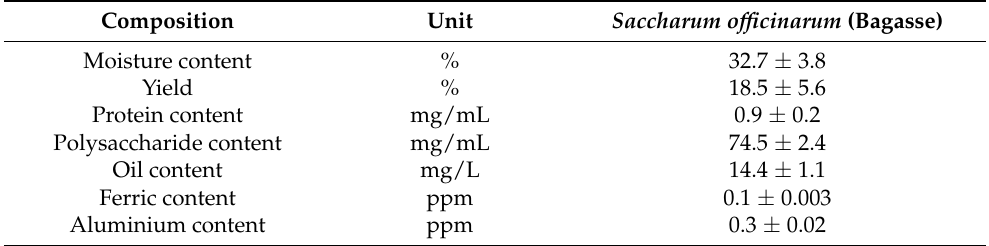
Table 3. Physicochemical composition of Saccharum officinarum . Composition